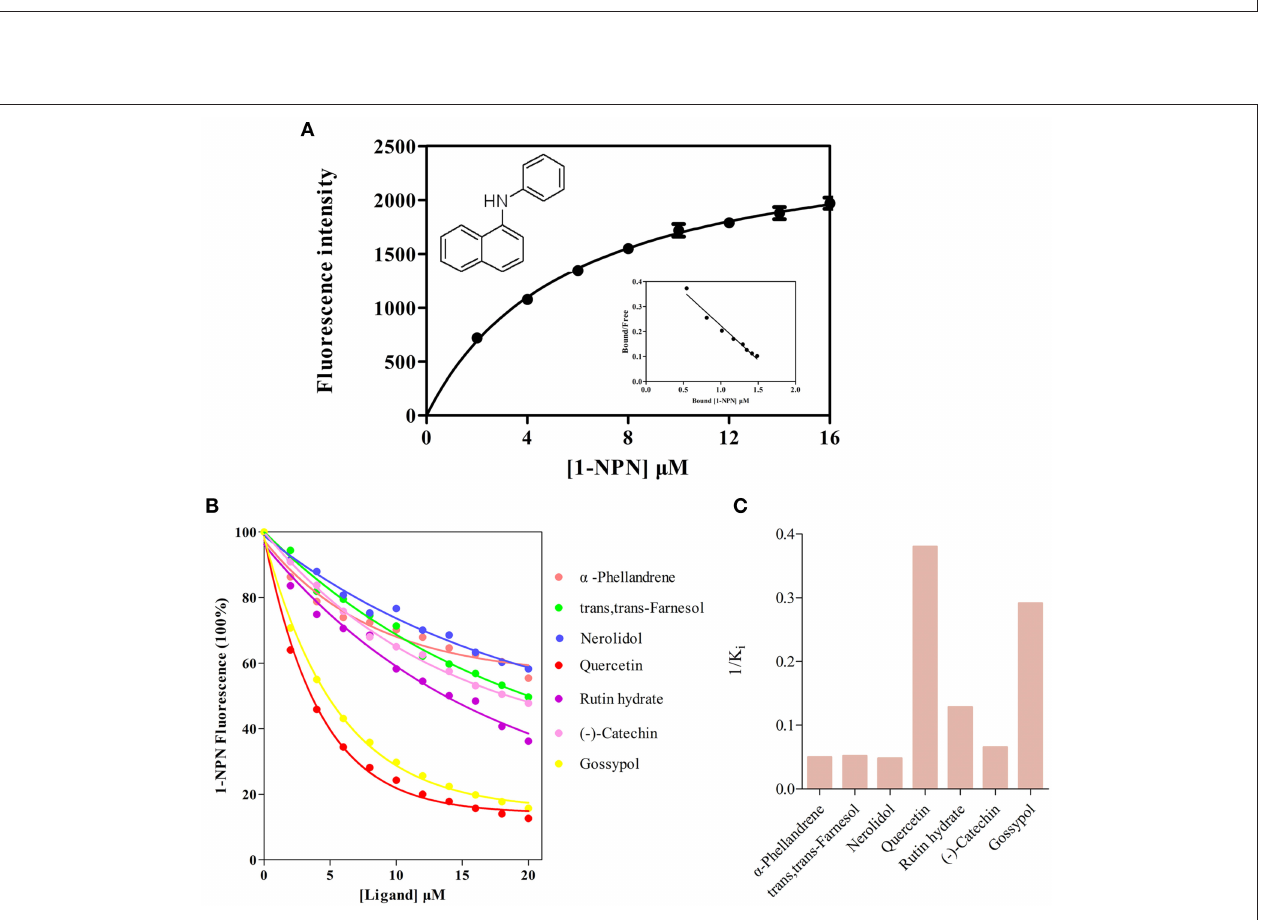
FIGURE 4 | Fluorescence competitive binding assay. (A) Binding curve and relative Scatchard plot of 1-NPN to AlinOBP11. The dissociation constant of the AlinOBP11/1-NPN complex was calculated as 5.86 ± 0.47 µ M. (B) Competitive binding curves of selected host plant compounds to AlinOBP11. (C) The reverse values of the dissociation constants (Ki) measured with putative ligands of AlinOBP11. A mixture of the recombinant AlinOBP11 protein and N-phenyl-1-naphthylamine (1-NPN) in 50mM Tris-Hcl buffer (pH 7.4) both at the concentration of 2 µ M was titrated with 1mM solutions of each competing ligand to the final concentration range of 2 to 30 µ M. Fluorescence intensities are reported as percent of the values in the absence of competitor. Data are represented as means of three independent experiments.